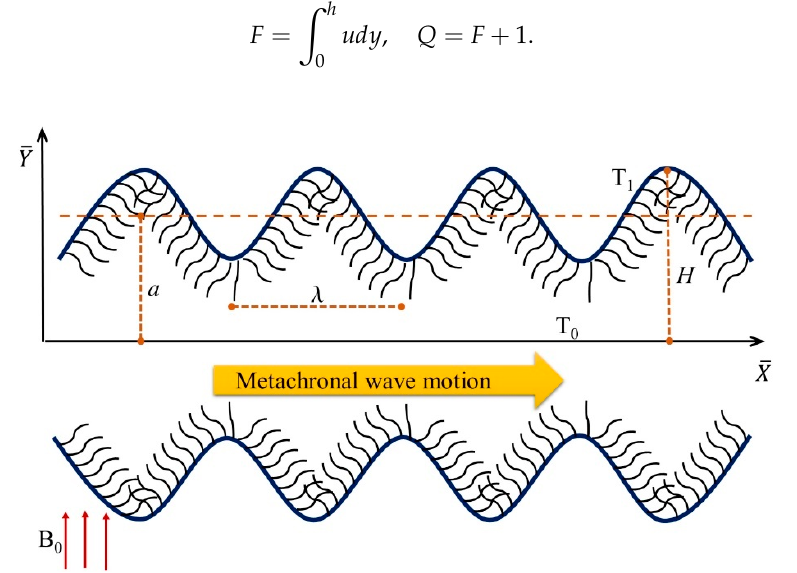
Figure 1. Physical geometry of the fluid flow in ciliated channel.